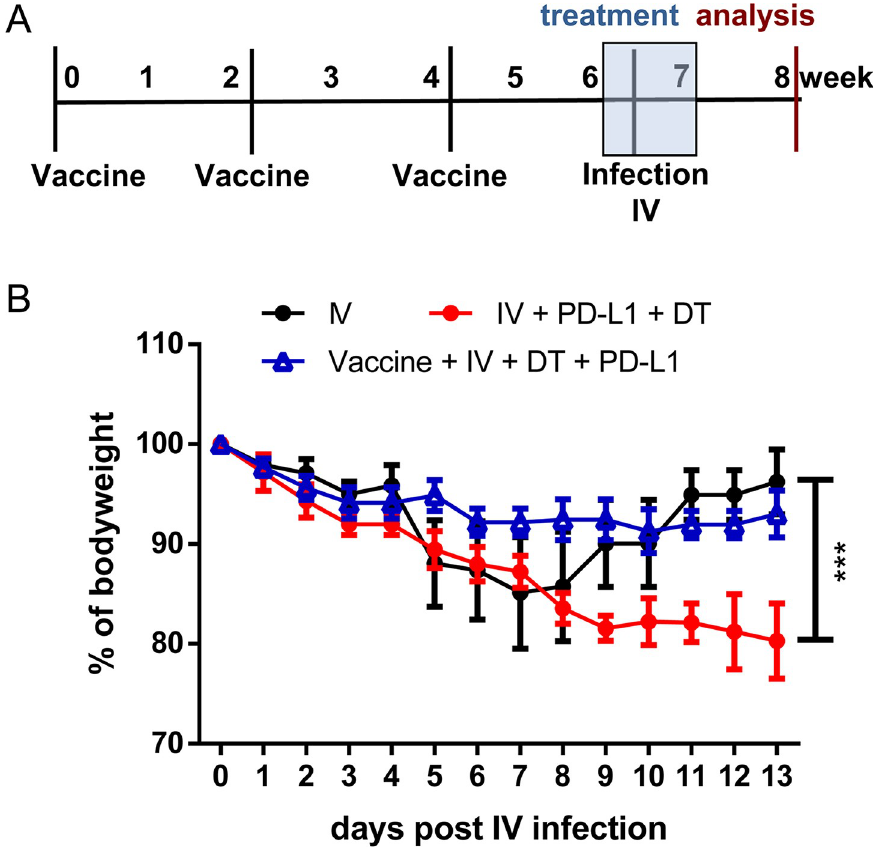
Fig 7. Vaccination prevents the development of immune-mediated pathology. DEREG mice were immunized with an inactivated influenza virus and treated with DT and anti-PD-L1 antibody ( A ). Weight reduction of mice infected with IV (black line), IV-infected and treated (blue line), and vaccinated, IV-challenged and treated (red line) ( B ). Data were pooled from 2 independent experiments with similar results. Statistically significant differences are indicated by asterisks ( ��� < 0.0005; non-parametric Mann-Whitney